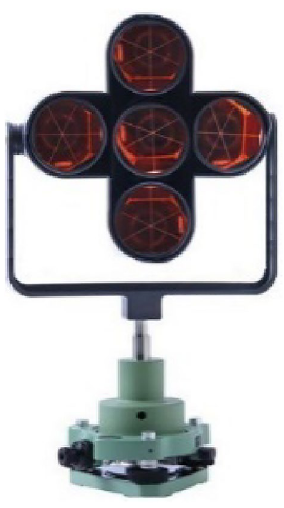
Figure 7. An integrated prism.